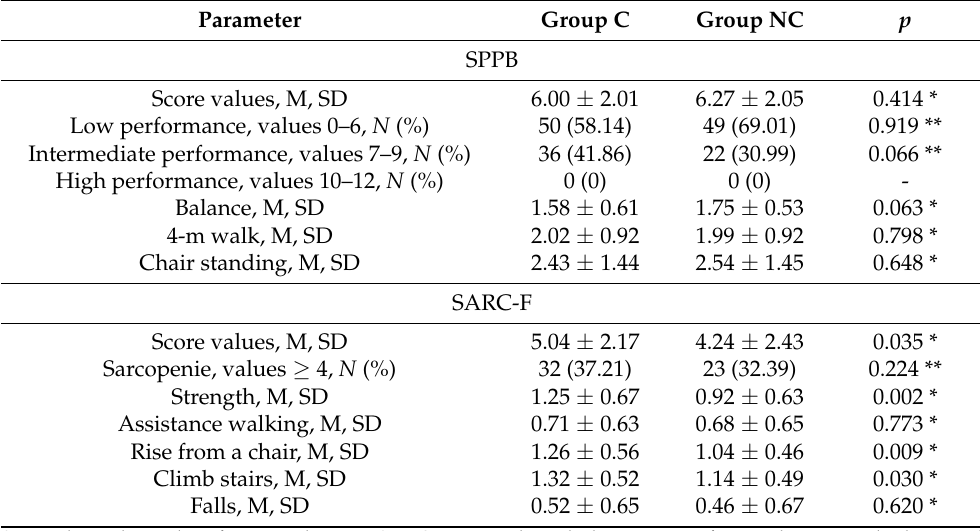
Table 4. SPPB and SARC-F score values of the groups.